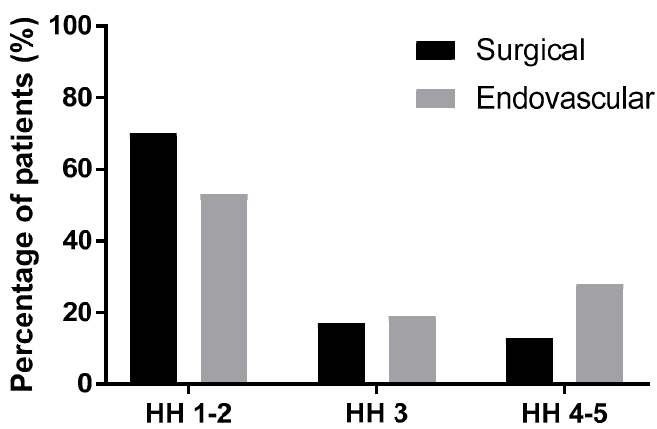
Figure 5. The modality of treatment according to Hunt–Hess grade (HH).